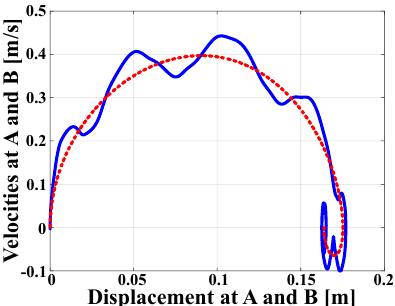
Figure 8. Phase plot at points A (solid line) and B (dashed